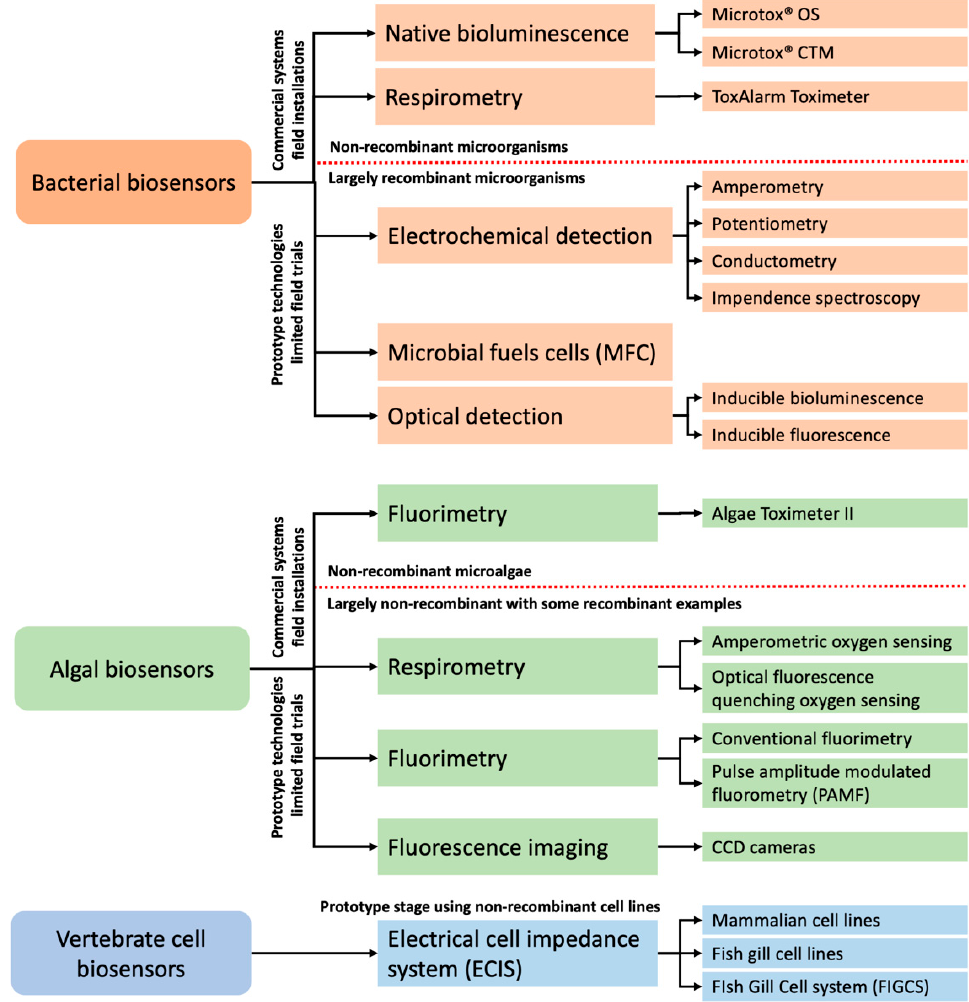
Figure 1. Overview of live-cell biosensing and biomonitoring systems for water quality assessment.